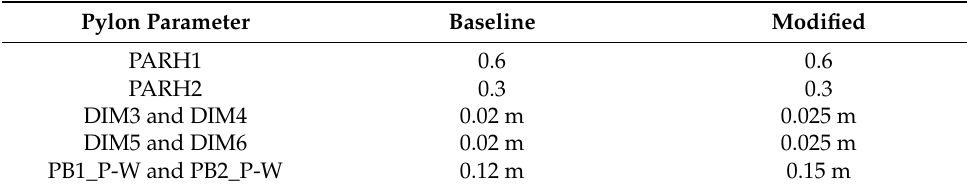
Figure 8. Visualization of the parameters for the pylon and engine modeling for the wing integration. Table 4. Defined pylon parameters for the baseline and the modified